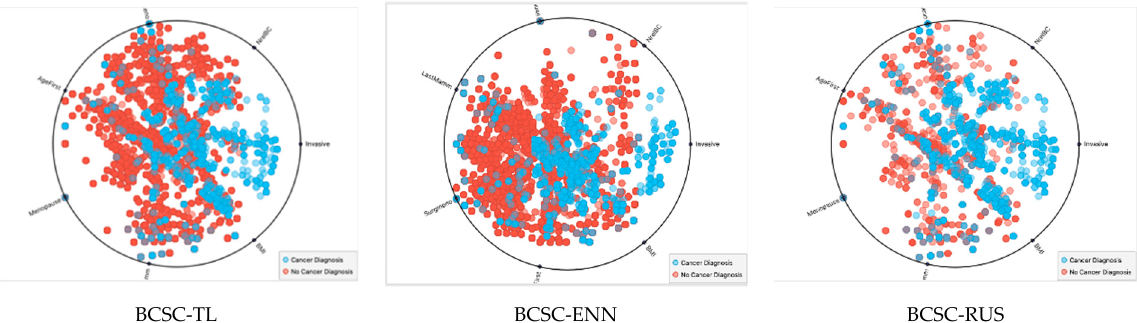
Figure 5. Effect of undersampling techniques on the BCSC dataset.